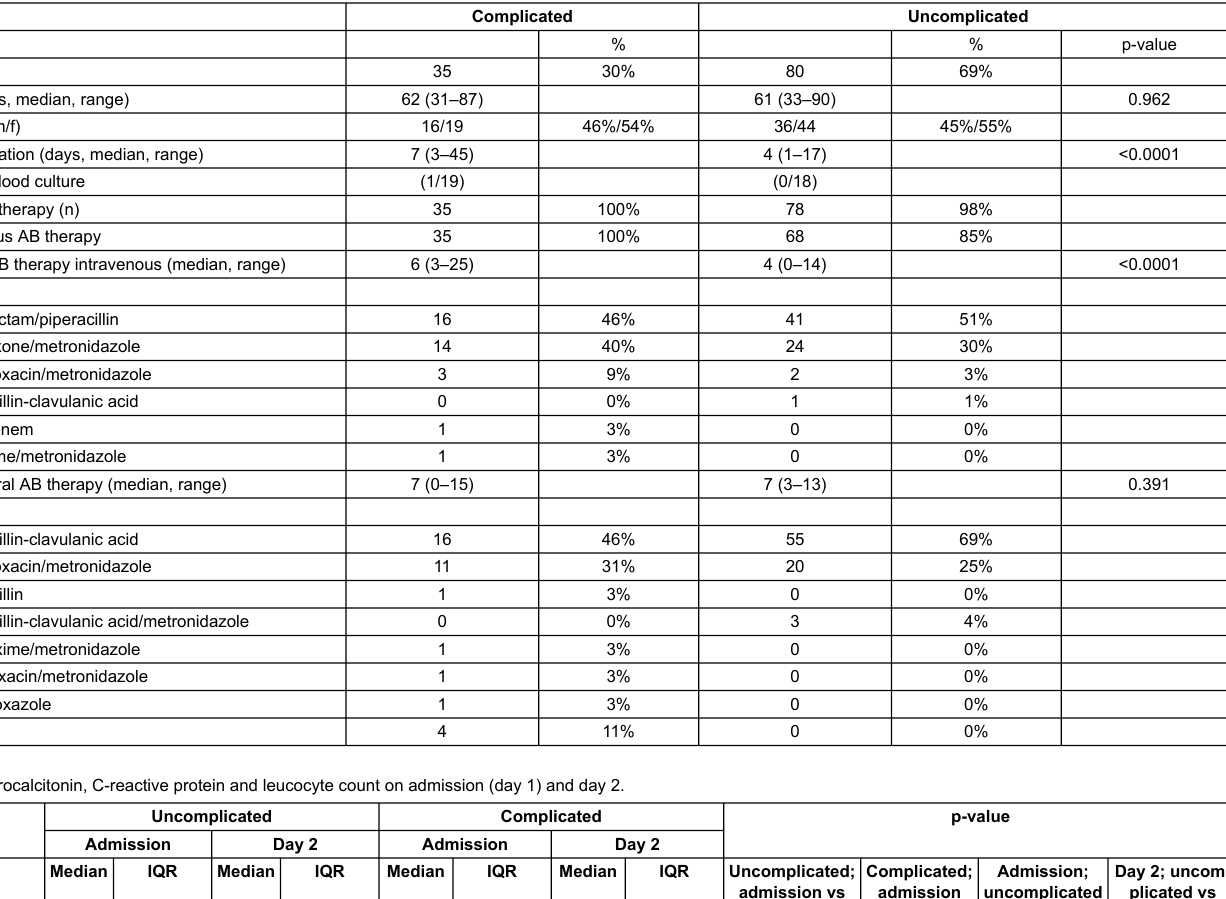
Table 1: Demographics and characterisation of antibiotic (AB) treatment of complicated and uncomplicated cases of diverticulitis.